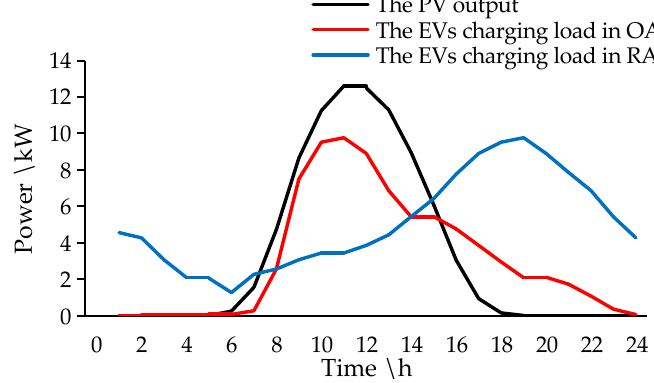
Figure 1. Schematic diagram of PV output and EV charging load in different areas.